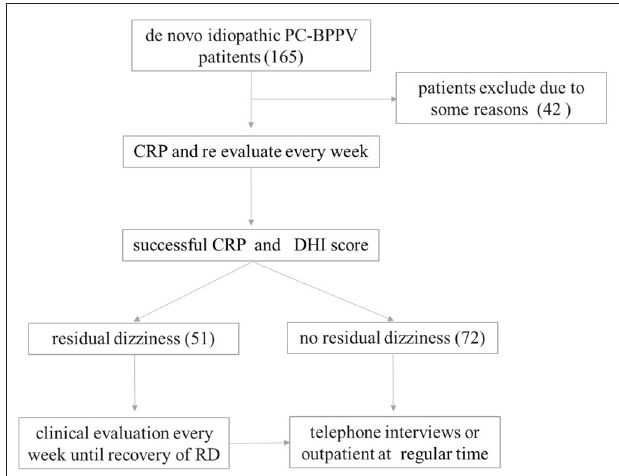
FIGURE 1 | Study flow diagram demonstrating patient enrollment and